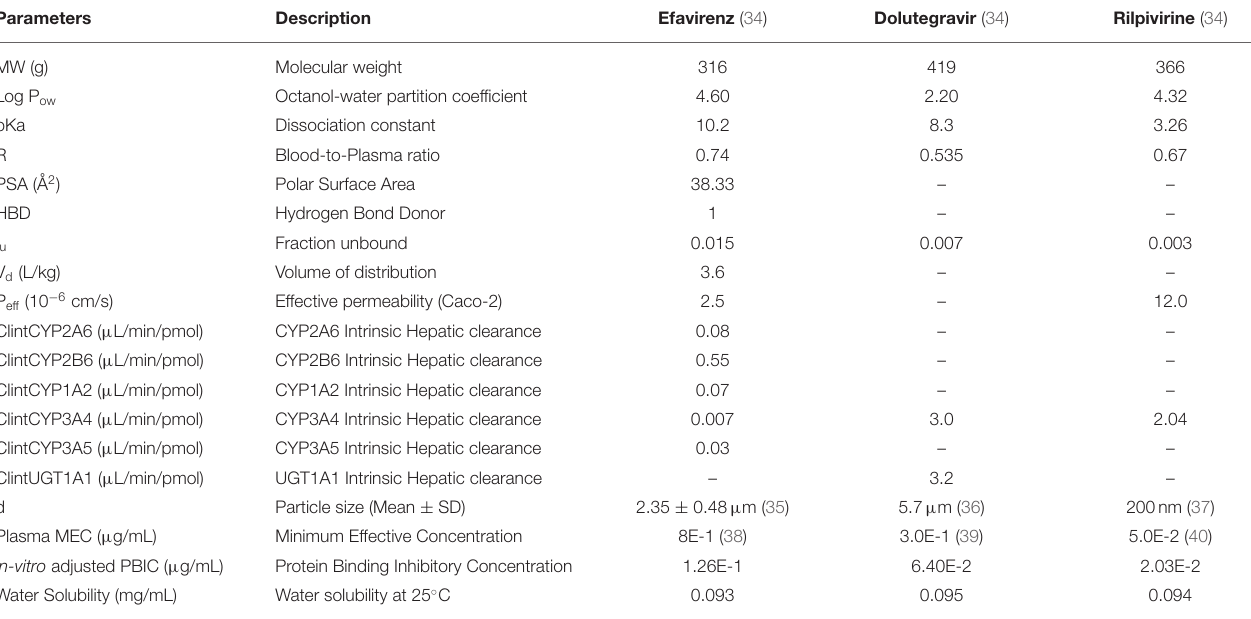
TABLE 1 | Drug-specific parameters for efavirenz, dolutegravir, and rilpivirine used in building the lymph-PBPK model. Parameters